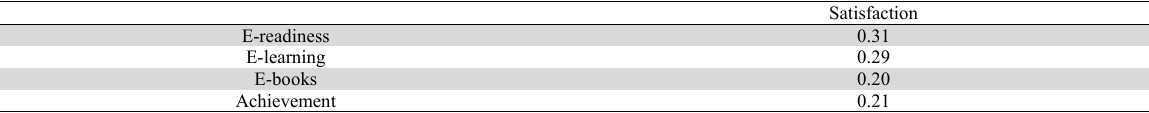
f 2 Effect Sizes Evaluation